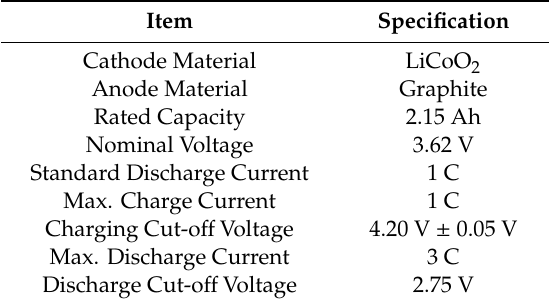
Table 1. Indicators of an ICR18650-22PM lithium-ion battery.